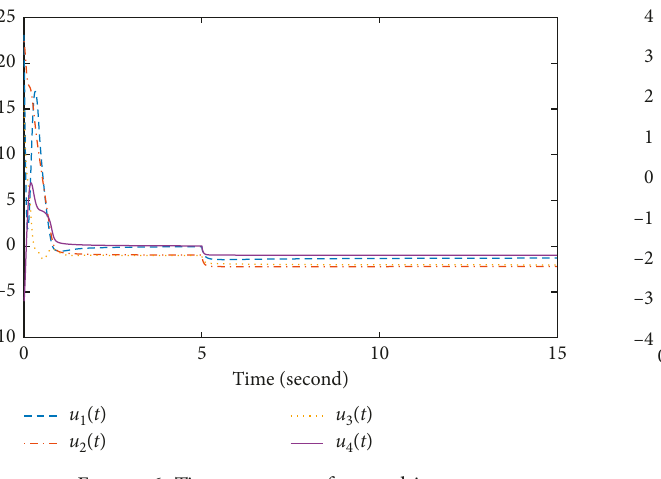
Figure 6: Time response of control inputs.